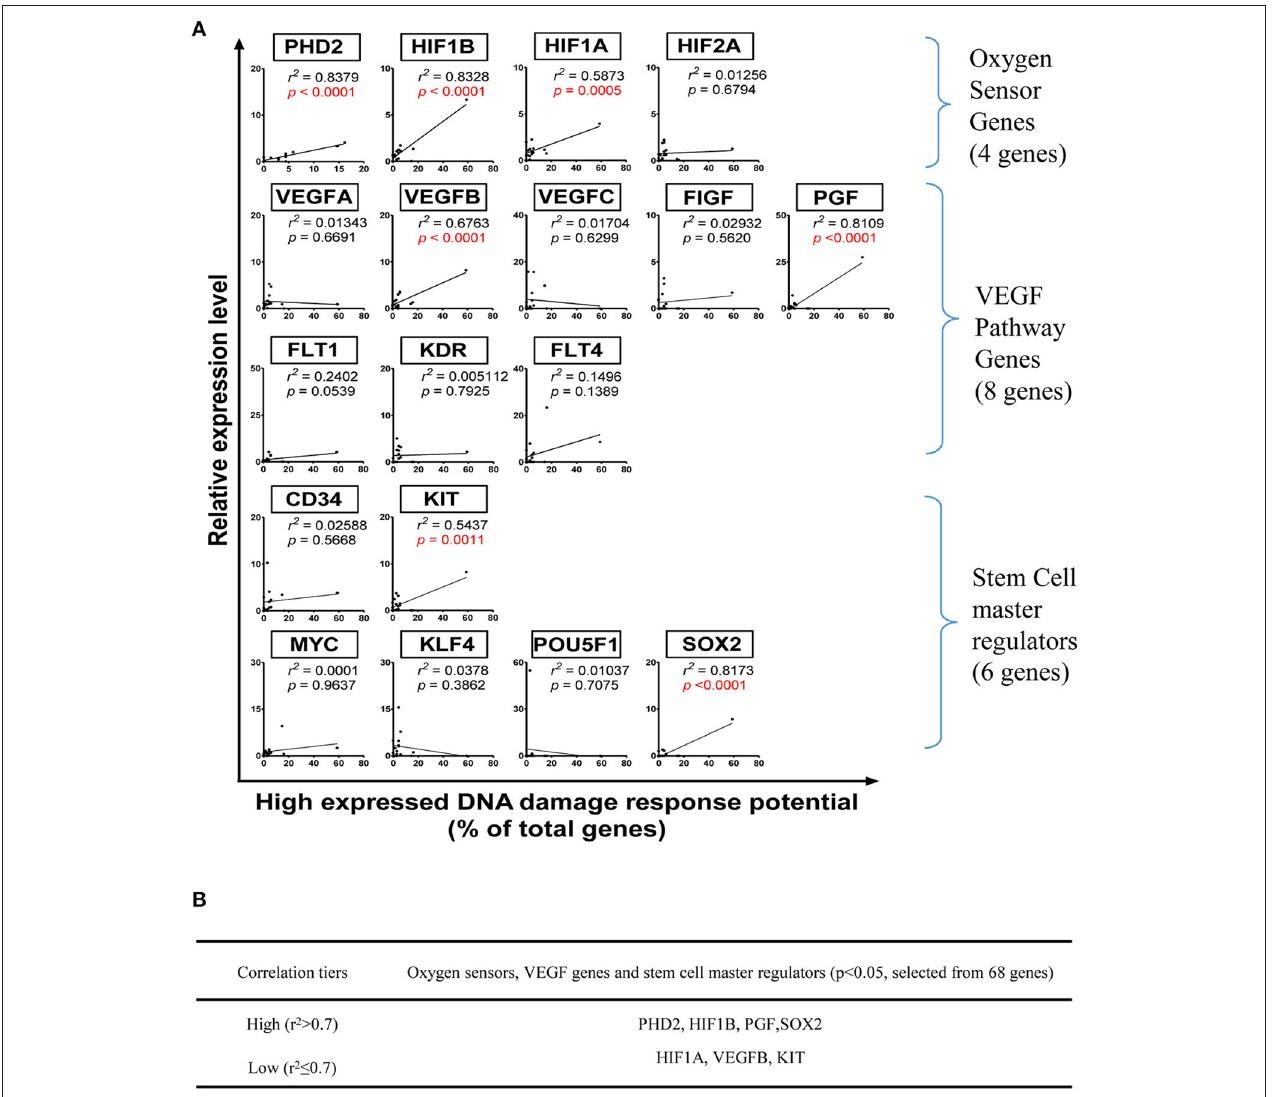
FIGURE 8 | Oxygen sensors, VEGF pathway regulators and stem cell master regulators regulate DNA damage response gene expression in human tissues. (Tissues: adipose tissue, blood, bone marrow, brain, embryonic tissue, heart, kidney, liver, lung, lymph node, muscle, pancreas, skin, spleen, thymus, vascular). (A) Correlation between mRNA relative expression levels and specific genes that act as Oxygen Sensor, VEGF pathway genes and stem cell master regulators. (B) Eleven genes with p < 0.05 were categorized into two tiers based on r 2 value. PHD2, Prolyl hydroxylase domain-containing protein 2; HIF1B, Hypoxia-inducible factor-1 beta; HIF1/2A, Hypoxia-inducible factor 1/2-alpha; VEGFA/B/C, Vascular Endothelial Growth Factor A/B/C; FIGF, C-fos-induced growth factor; FLT1/4, Fms related tyrosine kinase ¼ ; KDR, Kinase insert domain receptor; MYC, MYC proto-oncogene; KIT, KIT proto-oncogene receptor tyrosine kinase; KLF4, Kruppel like factor 4; POU5F1, POU class 5 homeobox 1; SOX2, SRY-box